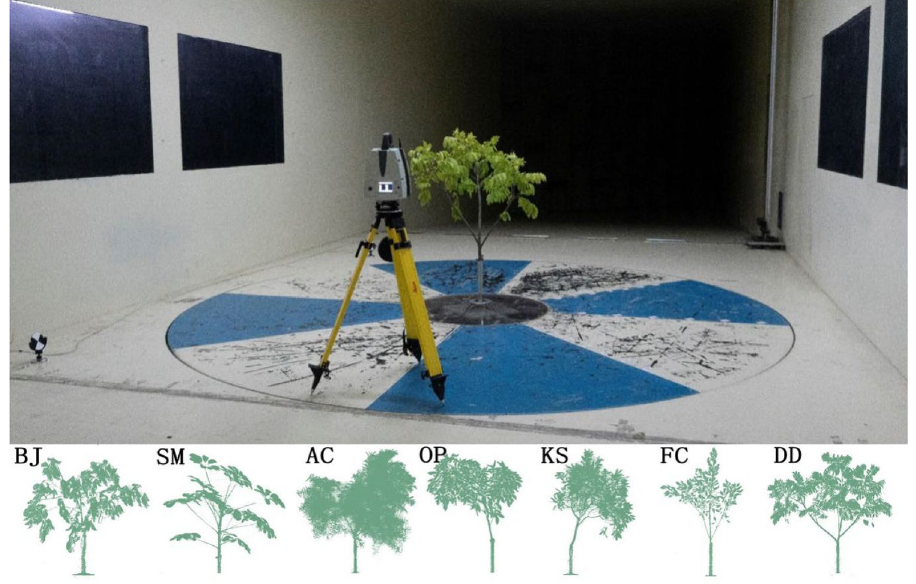
Figure 1. Process of laser scanning and captured photo of 7 species. BJ, SM, AC, OP, KS, FC, and DD are the abbreviations of Bischofia javanica , Schefflera macrostachya , Acacia confuse , Ormosia pinnata , Ficus concinna , Khaya senegalensis and Dracontomelon duperreanum ,